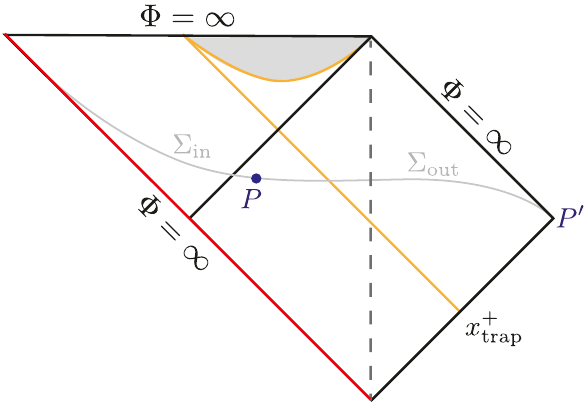
Figure 8 . To compute the generalized entropy S ( P ) we define a Cauchy surface Σ and consider a point P that splits it into a region Σ in and Σ out . Taking null derivatives of the generalized entropy we find a quantum trapped region (shaded gray) where the generalized entropy decreases in both null directions. The quantum trapped region develops much later than a scrambling time, but much earlier than the Page time: t ∗ (cid:28) t trap (cid:28) t Page